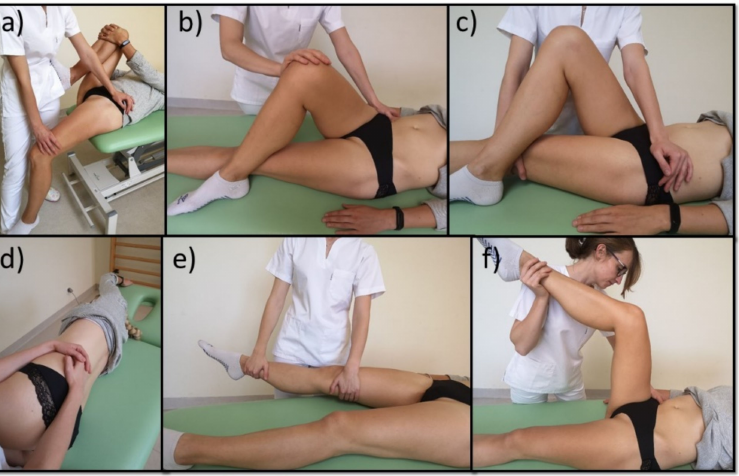
Figure 5. Post-isometric muscle release: ( a ) m. ilipsoas; ( b ) m. piriform; ( c ) m. m. tensor fasciae latae; ( d ) m. quadratus lumborum; ( e ) mm. adductors of the thigh; ( f ) mm. hamstring. In subgroup B, there were no interventions during the menstrual cycle. During the next menstrual period, the patients were asked to take ibuprofen at a dose of 3 × 400 mg daily for the duration of pain (Figure